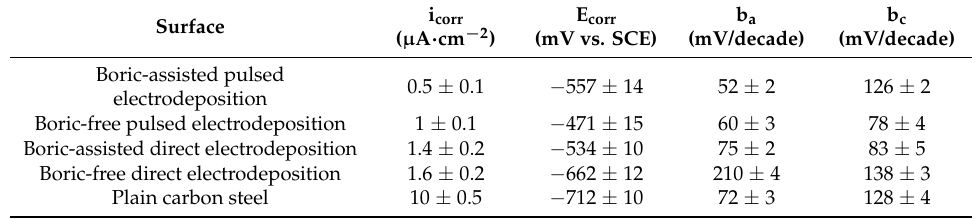
Table 1. Potentiodynamic polarization parameters of electrodeposited coatings in different conditions.